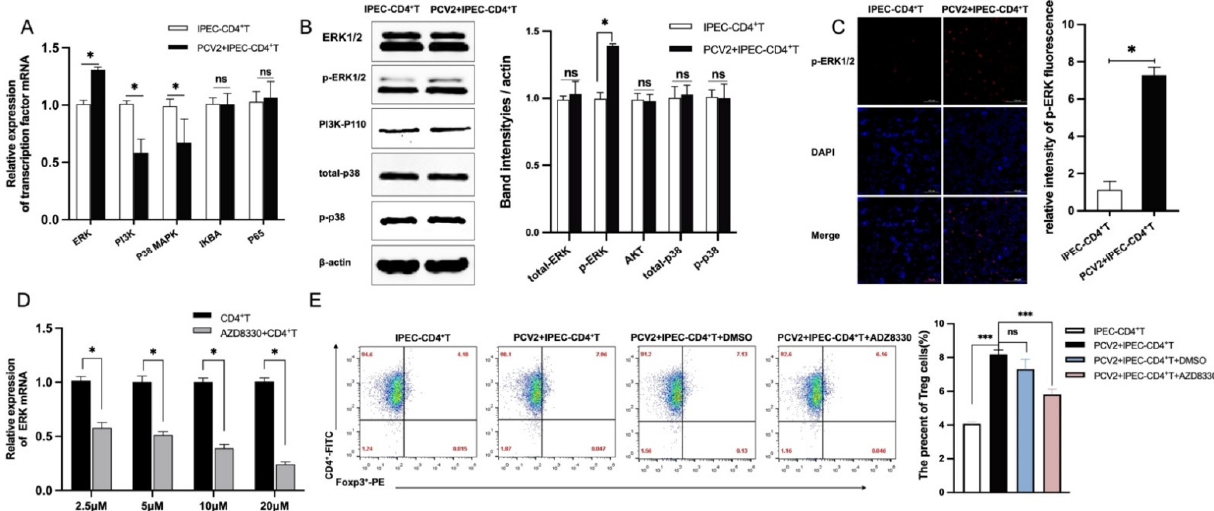
Figure 3. PCV2-infected IPEC-J2 increased the amount of Treg by activating ERK in CD4 + T cells. IPEC-J2 were infected with PCV2 or not infected for 48 h, and were then co-cultured with CD4 + T cells for 3 days. The mRNA expressions of ERK, PI3K, P38, IKBA and NF- κ B P65 in CD4 + T cells were detected by qPCR ( A ). Western blotting was used to test the protein expressions of p110 (PI3K- p110), ERK1/2 and phosphorylated ERK1/2 (p-ERK1/2), total p38 and phosphorylated p38(p-p38). The expression of each protein was quantified using ImageJ and normalized to β -actin levels ( B ). A confocal laser was used to detect the p-ERK1/2 in CD4 + T cells after 6 hours co-culture, and the intensity of p-ERK1/2 fluorescence was quantified by ImageJ ( C ). qPCR was used to detect the mRNA expressions of ERK in CD4 + T cells, which were treated with AZD8330 (AZD8330+ CD4 + T) or DMSO (CD4 + T) for 1 h ( D ). IPEC-J2 cells were infected with PCV2 or not infected for 48 h, and were then co-cultured with CD4 + T cells (treatment with 20 μ M AZD8330/DMSO for 1 h in advance) for 3 days. Flow cytometry was used to detect the percentage of Treg cells ( E ). All assays were performed in triplicate, with three technical repeats for each sample. *** p < 0.001; * p < 0.05; ns, No Significant. To determine whether the expansion of Treg cells is dependent on ERK activation, CD4 + T cells were treated with AZD8330 (a selective ERK inhibitor). The best AZD8330